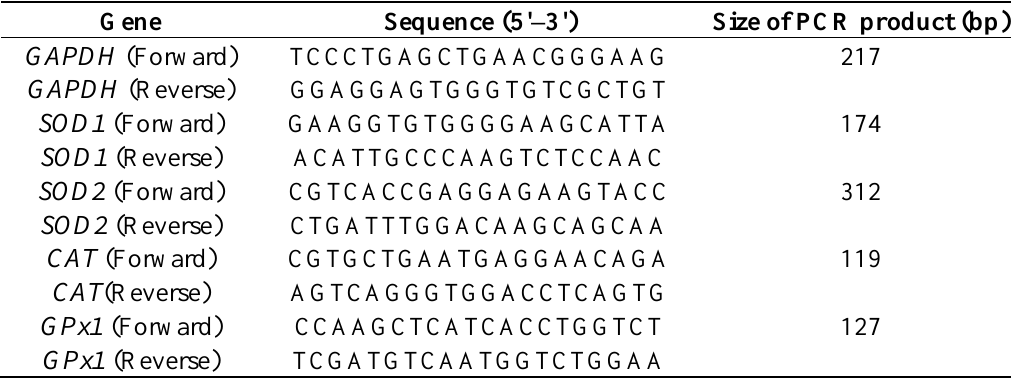
Table 2. Primer sequences for quantitative real-time